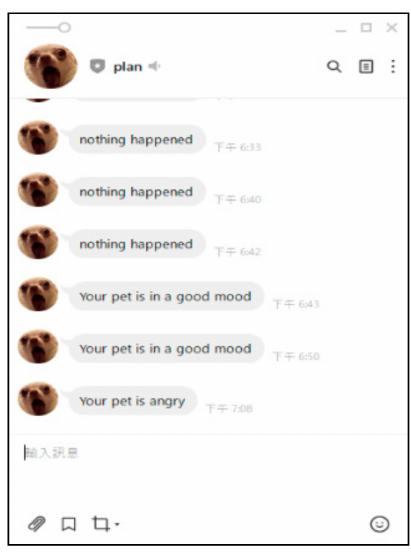
Figure 8. Communication